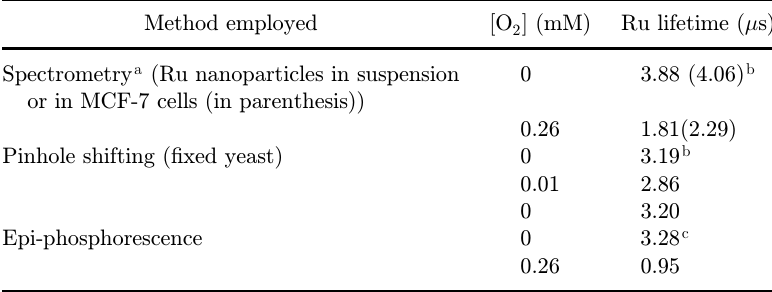
Table 1. Lifetime of Ru nanoparticles in suspension or electroporated into MCF-7, ¯xed yeast or HDF cells under di®erent gas phases (expressed as equivalent dissolved [O 2 ] mM), as assayed by spectrometry (Ru nanoparticles in suspension, or in MCF-7 cells (in parentheses)).